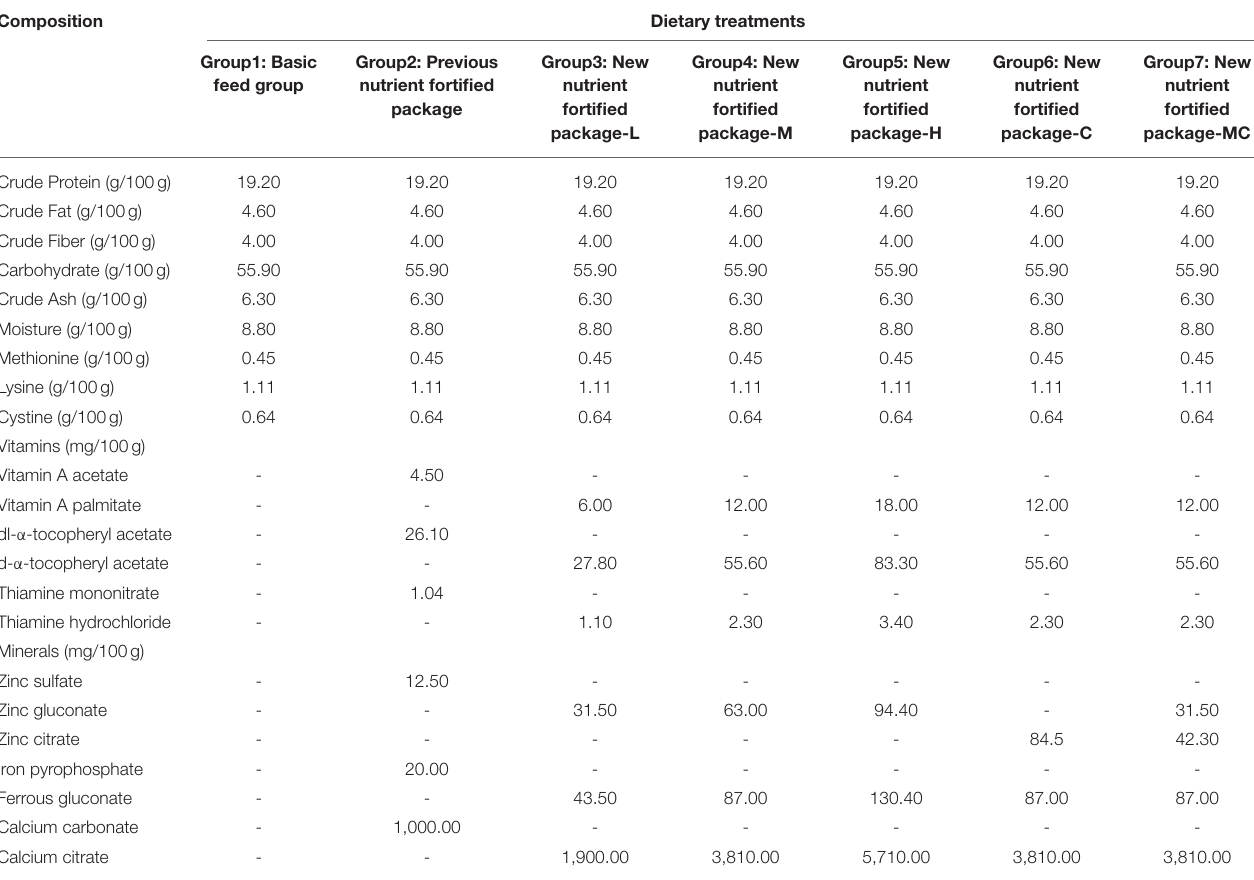
TABLE 1 | Grouping and dosing of experimental